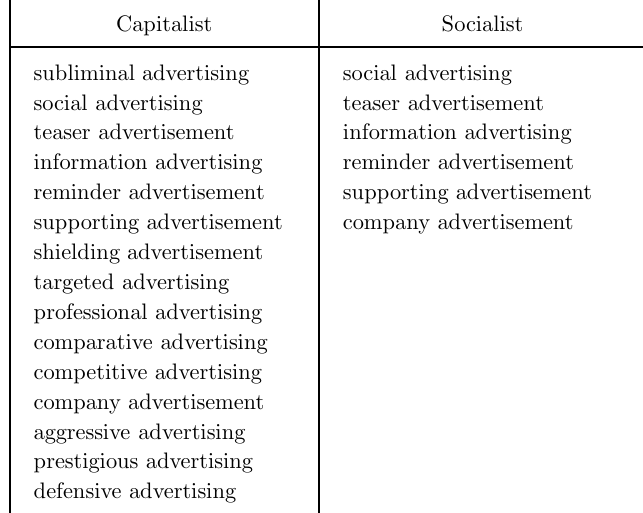
Figure 3. Dichotomy of advertising types depending on the political system